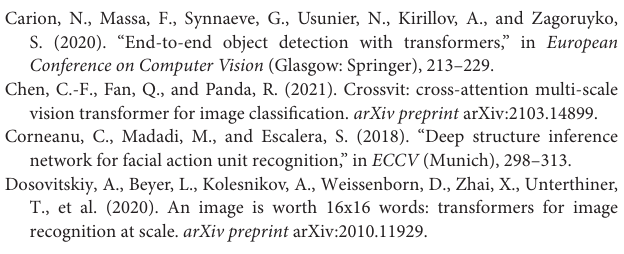
comparable AU detection performance. Visualization results show the superiority and feasibility of our proposed